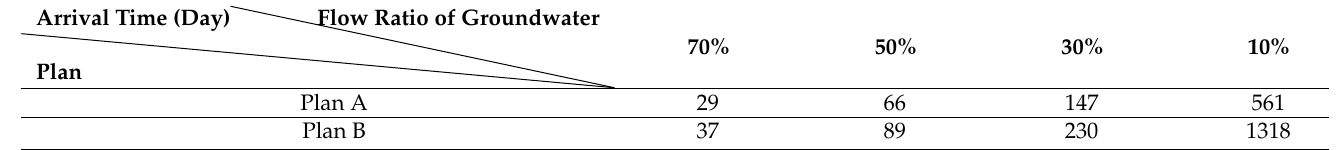
Figure 9. The bar graph of composition of flow quantity in pumping well BC1604 with the change in time. Note: ( A ) ‐ Plan A; ( B ) ‐ Plan B. Table 1. Comparison of the day for plan A and plan B to reach the corresponding “flow ratio of